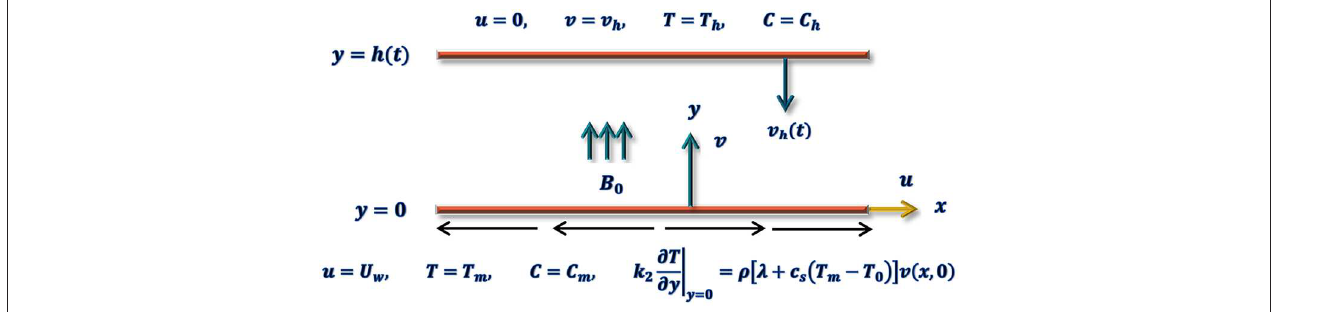
FIGURE 1 | Physical situation of the problem.